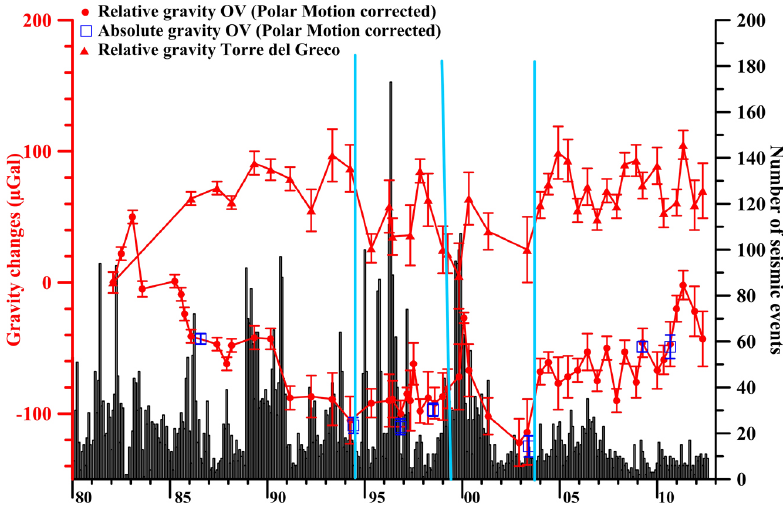
Figure 2. Gravity changes over the 1982-2012 period at two selected stations and comparison with the occurrence of the seismic activity (black bars) recorded at the station located at the Osservatorio Vesuviano, on the volcanic structure. The two selected stations are respectively lo- cated on the top (Osservatorio Vesuviano, OV – red full circles) and at the base (Torre del Greco – red full triangles) of the volcano. The blue open squares overlapping the curve referred to the Osservatorio Vesuviano station indicate the gravity changes there measured by absolute gravimetry. The cyan vertical lines delimitate the main recognized time intervals discussed in the